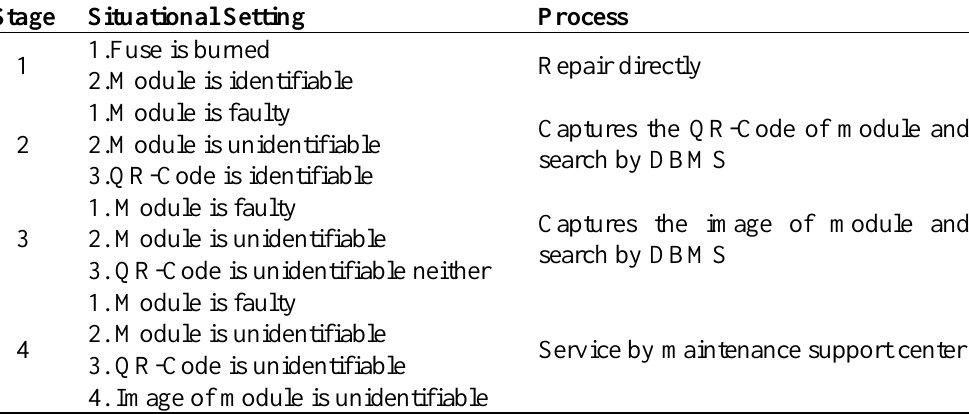
Table 1. Four-stage operations and situational